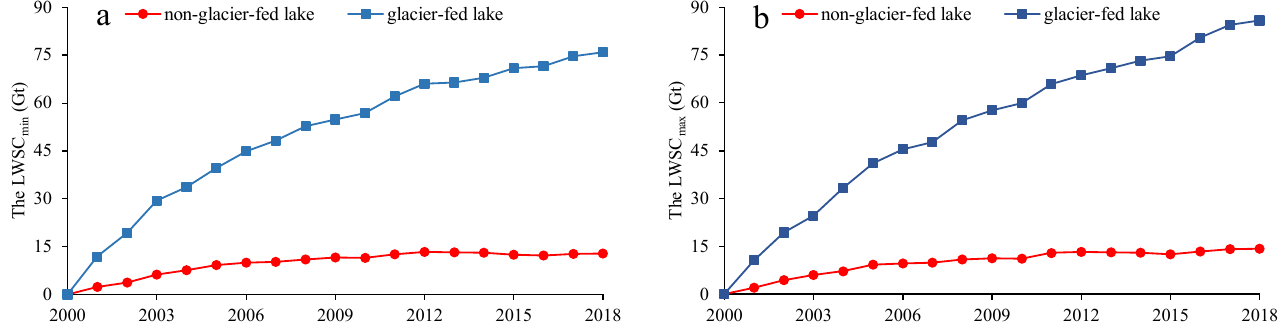
Figure 9. Distribution of lakes and regions on the TP. Regions of 1-7 represent non-glacier-fed lakes basins, regions of 8-17 represent glacier-fed lakes basins.